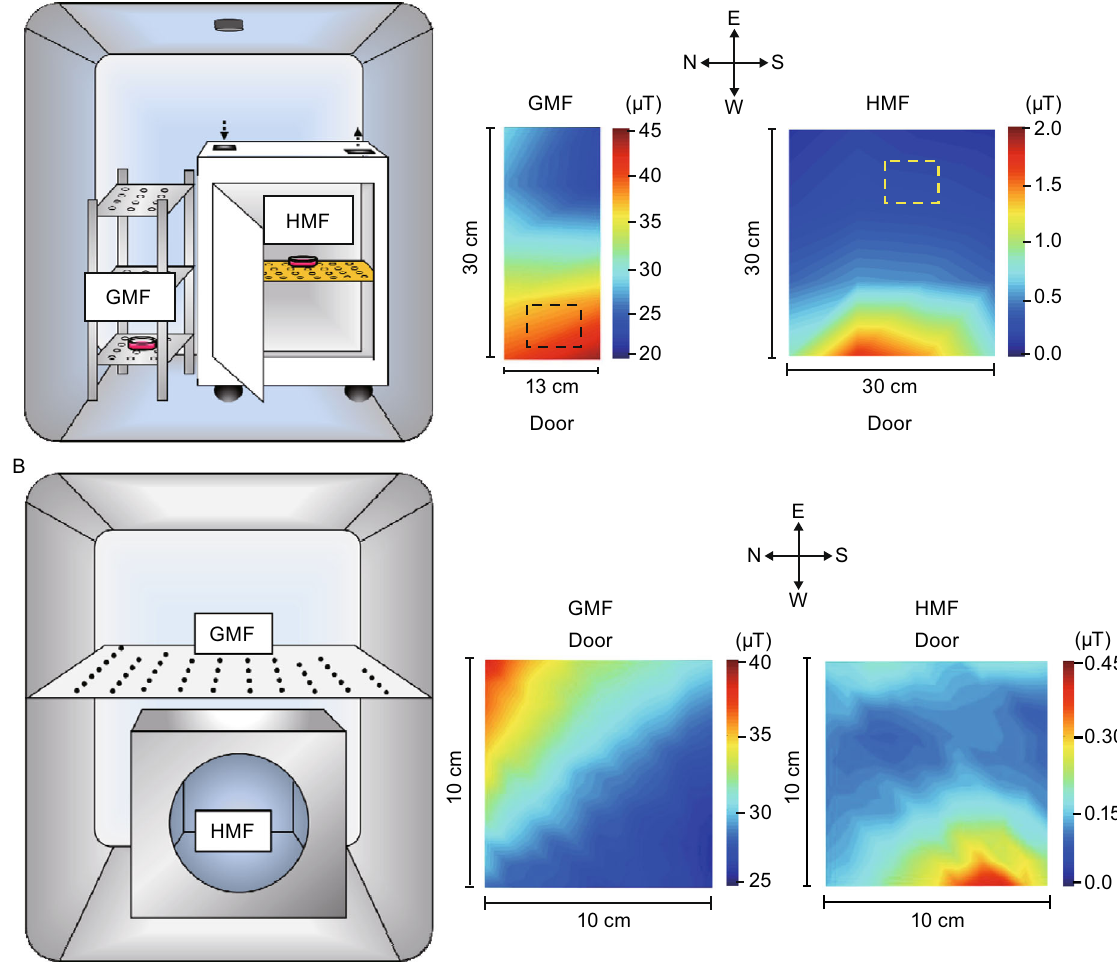
Figure 1. The experimental set ups for HMF simulation. (A) The HMF cell incubation system. The permalloy magnetic shielding chambers in the incubators provide the HMF (HMF, <0.2 μ T). The GMF control and the HMF-exposed cells were incubated on the bottom fl oor of the steel shelf (GMF, ∼ 40 μ T) and the permalloy chamber, respectively. (B) The HMF enzyme incubation system. The control cells were incubated on the steel shelf (GMF, ∼ 30 μ T). The distributions of SMF intensities were shown on the right. Rectangles with dashed lines demarcate the positions for